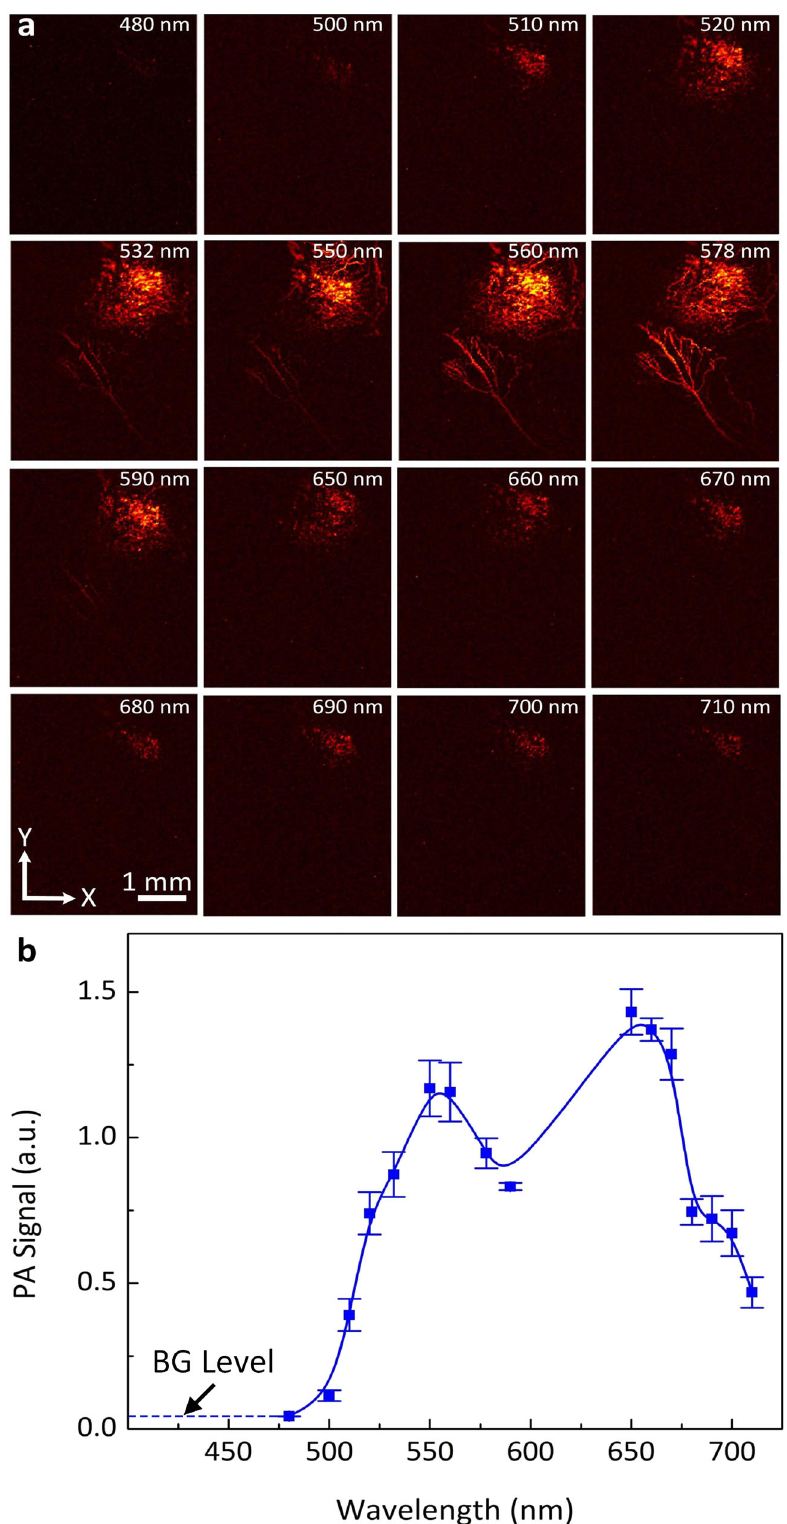
Fig. 5 In vivo spectroscopic PAM imaging of CNV. a Spectroscopic PAM images acquired at the different excitation laser wavelengths ranging from 480 to 710 nm. b Quantitative measurement of spectroscopic PA signal as a function of wavelength. BG background. Source data are provided as a Source Data fi